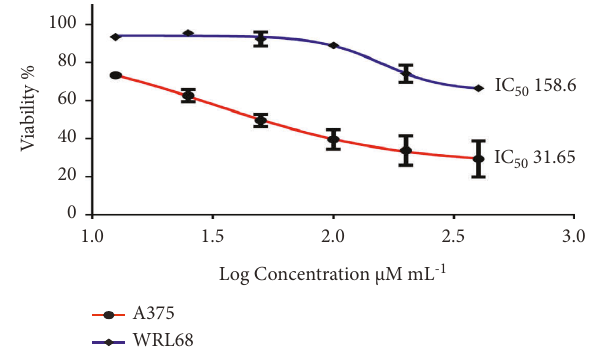
Figure 8: The cytotoxicity of green synthesized silver nanoparticles against A375 human melanoma cell lines and WRL68 normal cell